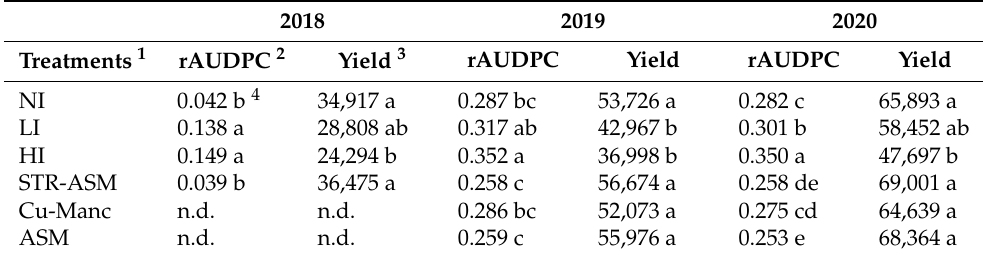
Table 1. Effect of initial inoculum level and bactericide programs on the progression of bacterial spot based on relative area under disease progress curve (rAUDPC) and resulting marketable yield of tomato “HM1823” over three